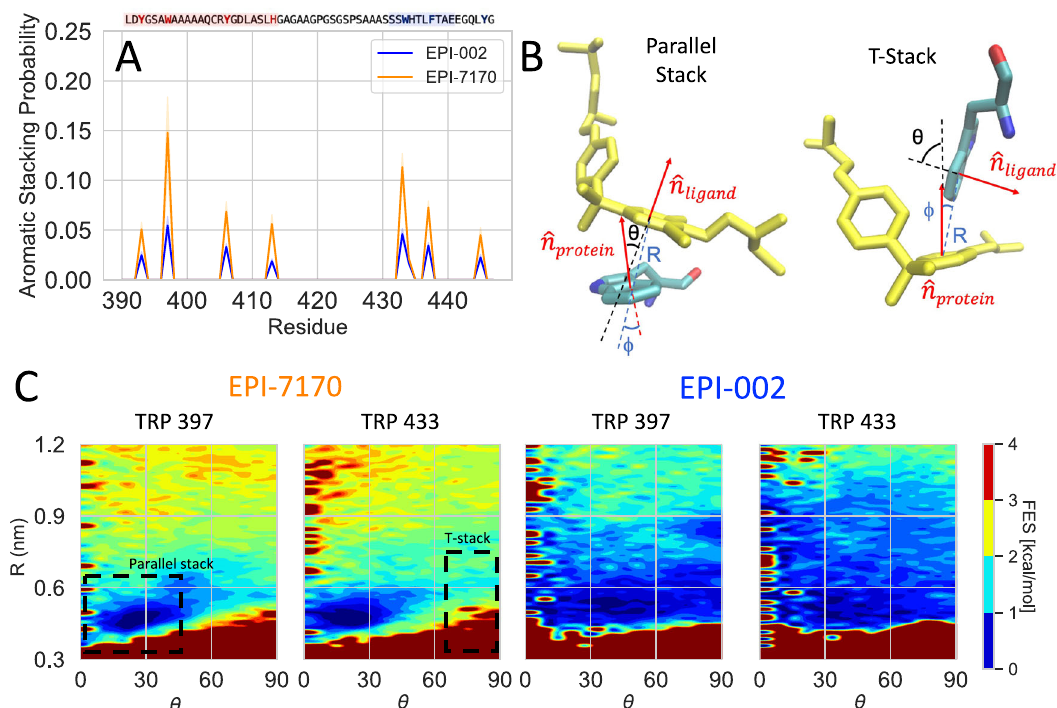
Fig. 5 | Aromatic stacking interactions in the Tau-5 R2_R3 :EPI-002 and Tau- 5 R2_R3 :EPI-7170 bound ensembles. A Populations of aromatic stacking contacts between aromatic sidechains of Tau-5 R2_R3 and aromatic rings of EPI-002 and EPI- 7170 were observed in the 300K replica of explicit solvent REST2 MD simulations. Populations are presented as mean values±statistical error estimates from block- ing. B De fi nition of angles and distances used to de fi ne stacking orientations and examplesofparallelstackedandT-stackedconformationsbetweenEPIcompounds andatyrosinesidechain.Foraproteinaromaticringandaligandaromaticring,Ris de fi ned as the distance between ring centers, ^ R is de fi ned as the unit vector